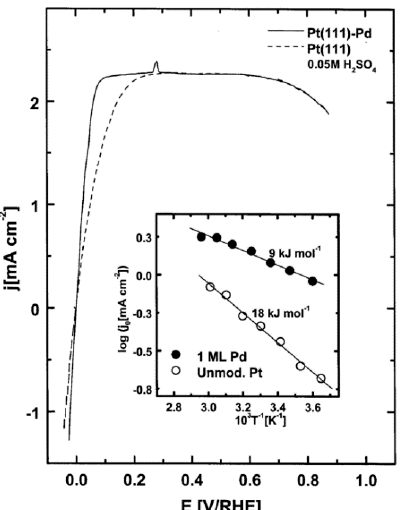
Figure 3. Main: polarization curves for hydrogen evolution/oxidation on Pt(111) and on Pt(111) modified by Pd, in acid solution (rotation rate 1600 rpm). Inset: Arrhenius plots for hydrogen evolution/oxidation on Pt(111) and on Pt(111) modified by Pd. Reprinted from Reference [32], copyright (2000), with permission from John Wiley & Sons.